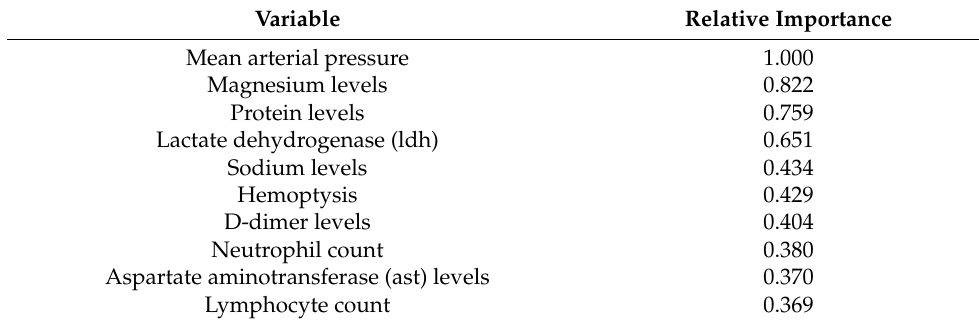
Table 5. Relative importance of top 10 variables used by the random forest classifier according to mean decrease accuracy algorithm (scaled to the most important